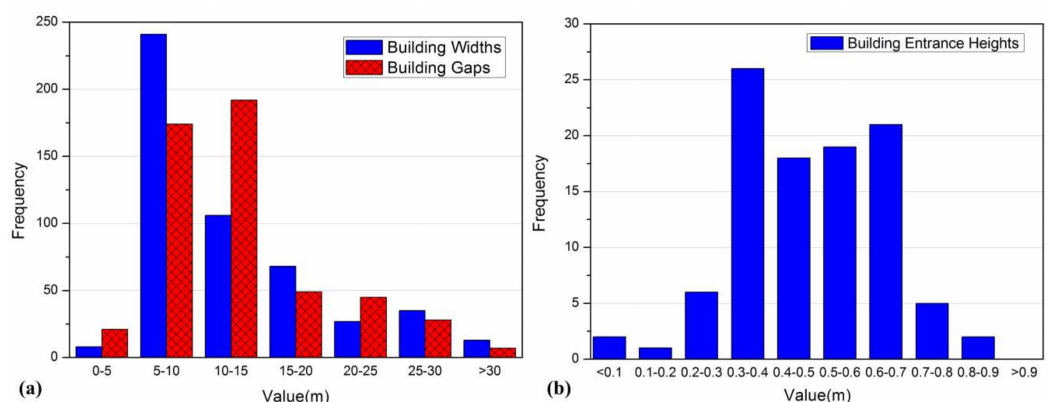
Figure 7. Histogram of building parameters in the study area: ( a ) building sizes and gaps; and ( b ) building entrance